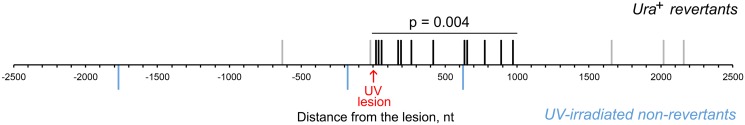
UV lesion bypass is associated with increased mutagenesis downstream of the lesion.The position of the presumed UV lesion at the ura3-G764A mutation site is indicated in red. Distribution of untargeted mutations in UV-induced Ura+ revertants is shown above the horizontal scale bar. Each vertical line represents a single mutation. Mutations found within 1000 bp downstream from the lesion are in black, those in other regions are in grey. Blue lines below the horizontal scale bar represent mutations found in UV-induced Canr mutants of the ura3-G764A strain. The data are based on DNA sequence analysis of 165 independent Ura+ revertants and 161 independent Canr mutant. P-value (Fisher’s exact test) indicates the significance of differences in the frequency of mutation in the 1-kb region between Ura+ revertants and Canr controls.